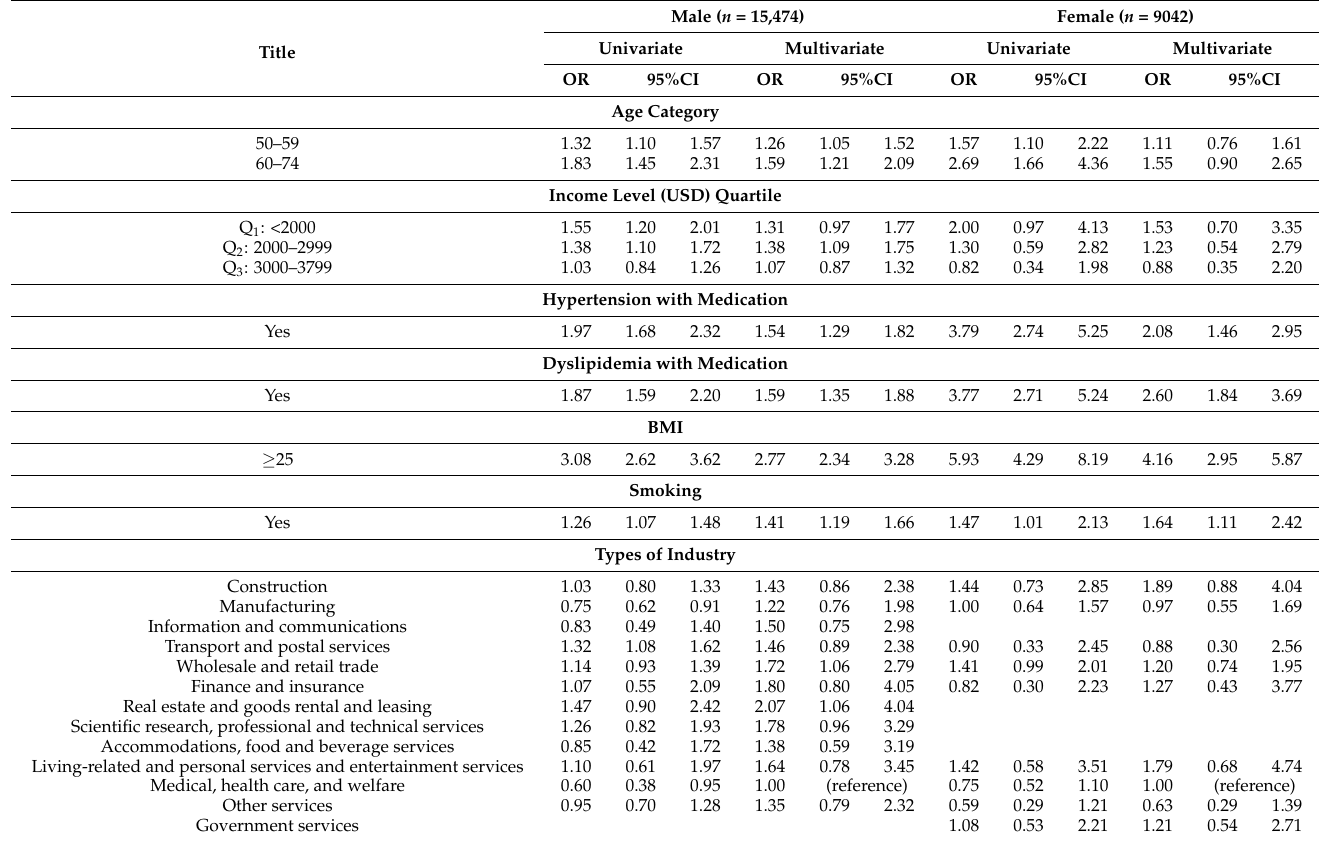
Table 2. Odds ratios and 95% confidence intervals for the onset of